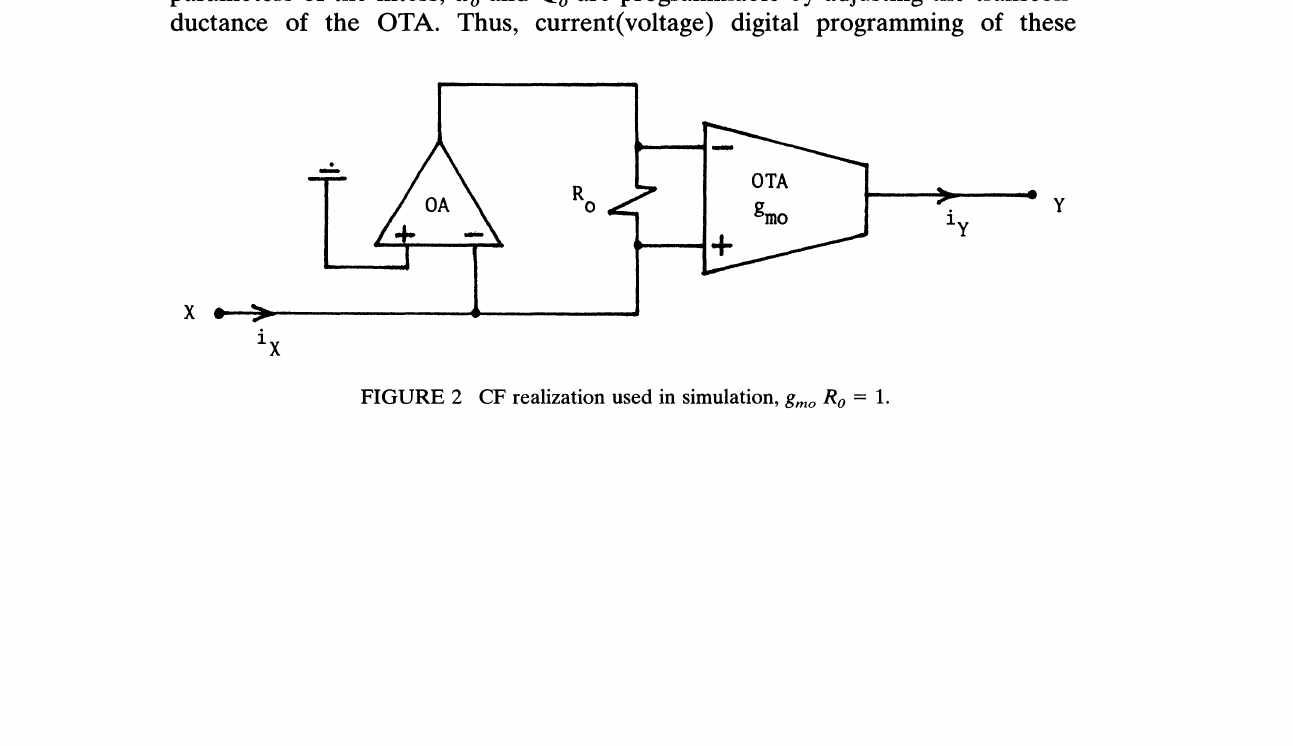
FIGURE 2 CF realization used in simulation, gmo